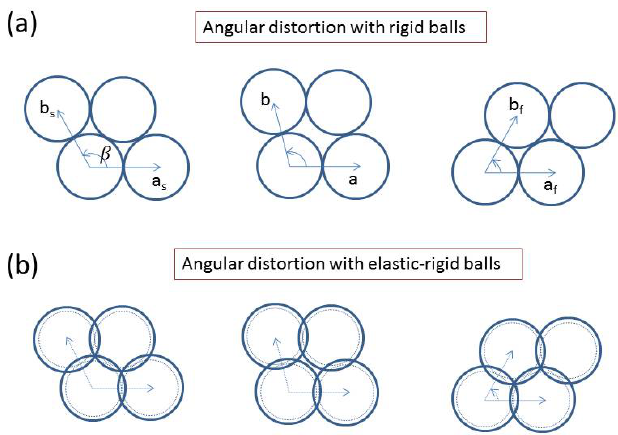
Figure 14. Angular distortive model, ( a ) with hard-spheres; ( b ) with elastic-hard spheres.